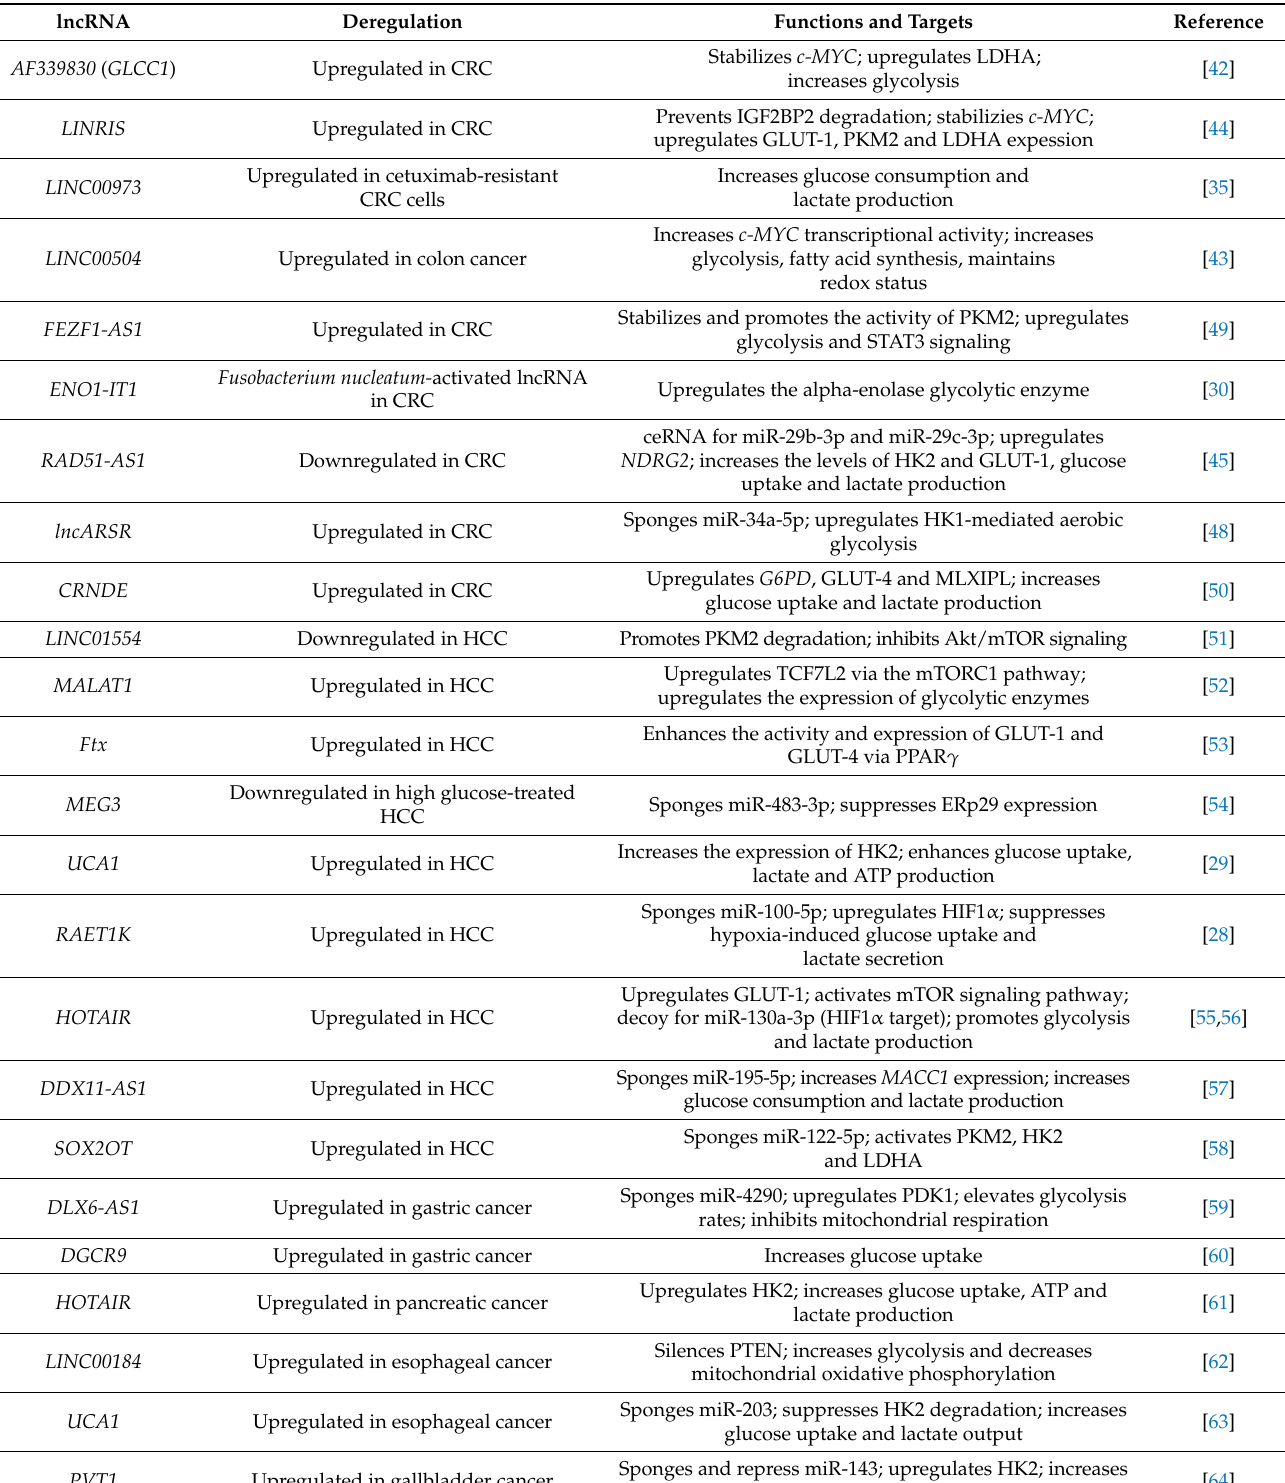
Table 1. Examples of lncRNAs implicated in glucose metabolism alteration in gastrointestinal (GI) cancers.